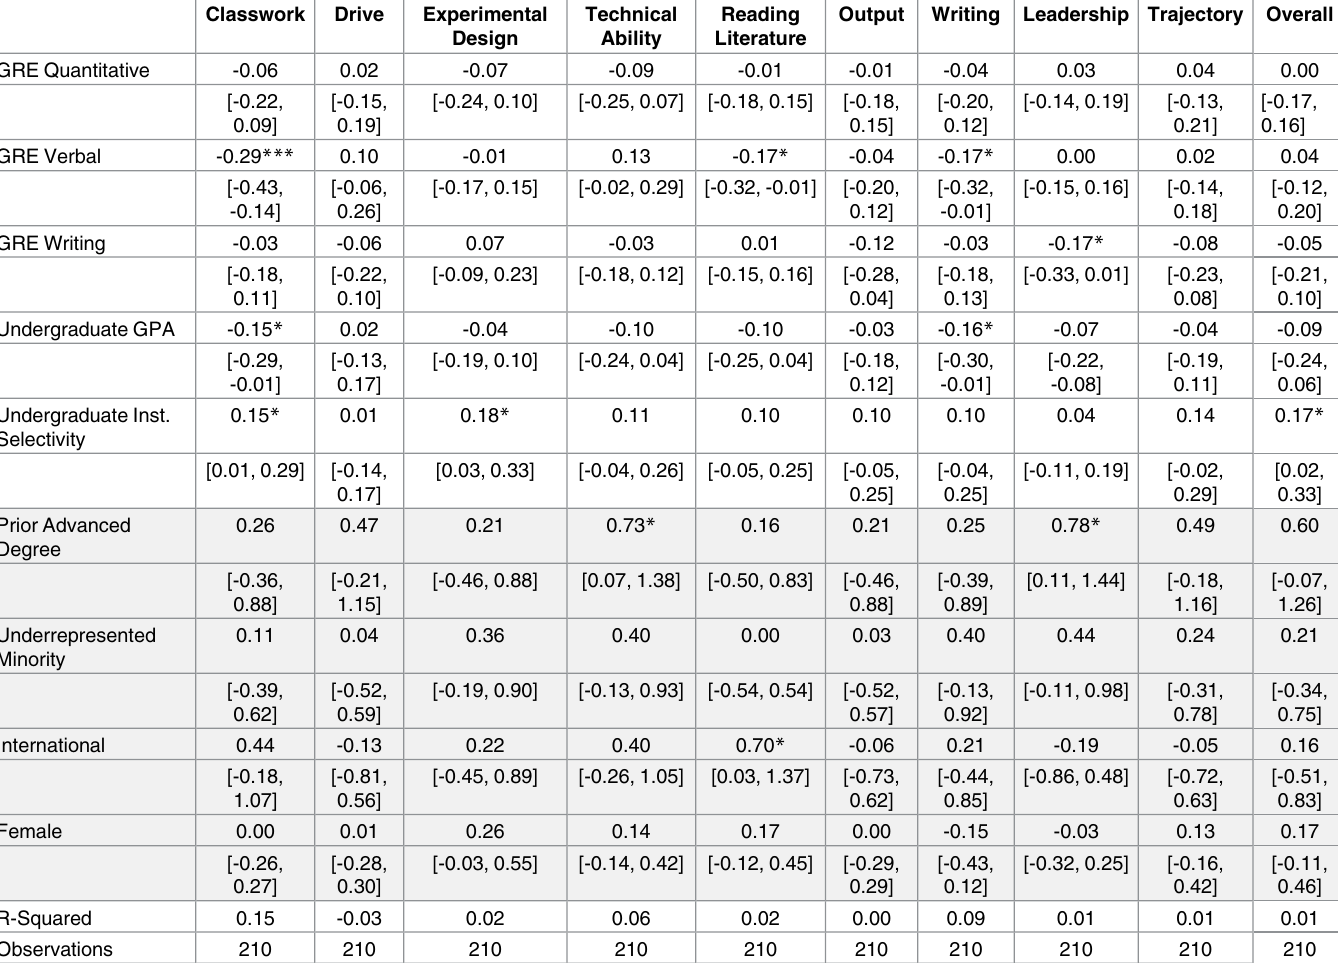
Standardized regression coefficients and 95% confidence intervals are reported for continuous variables. Coefficients on the binary variables are shaded gray and report the standard deviation change in the outcome by moving from 0 to 1 on the binary variable. Cohort fixed effects are included for each model. Adjusted R-squared is presented for each